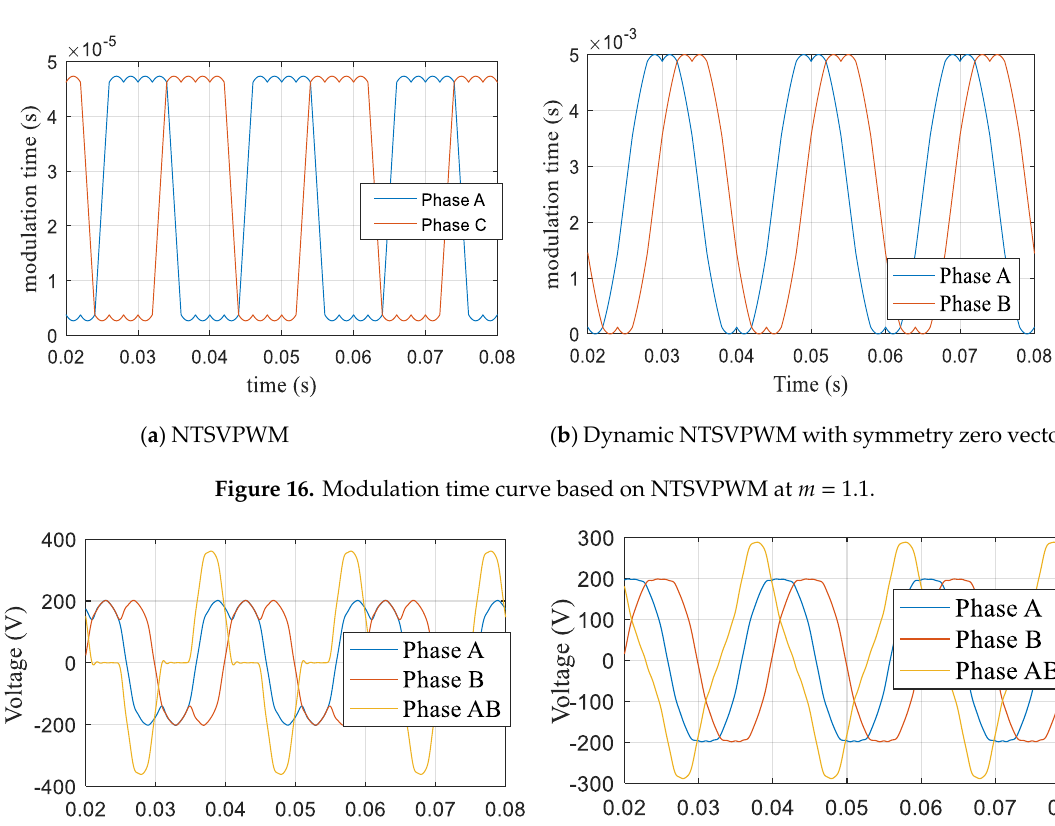
Figure 17. A and B phase voltage at m = 1.1.